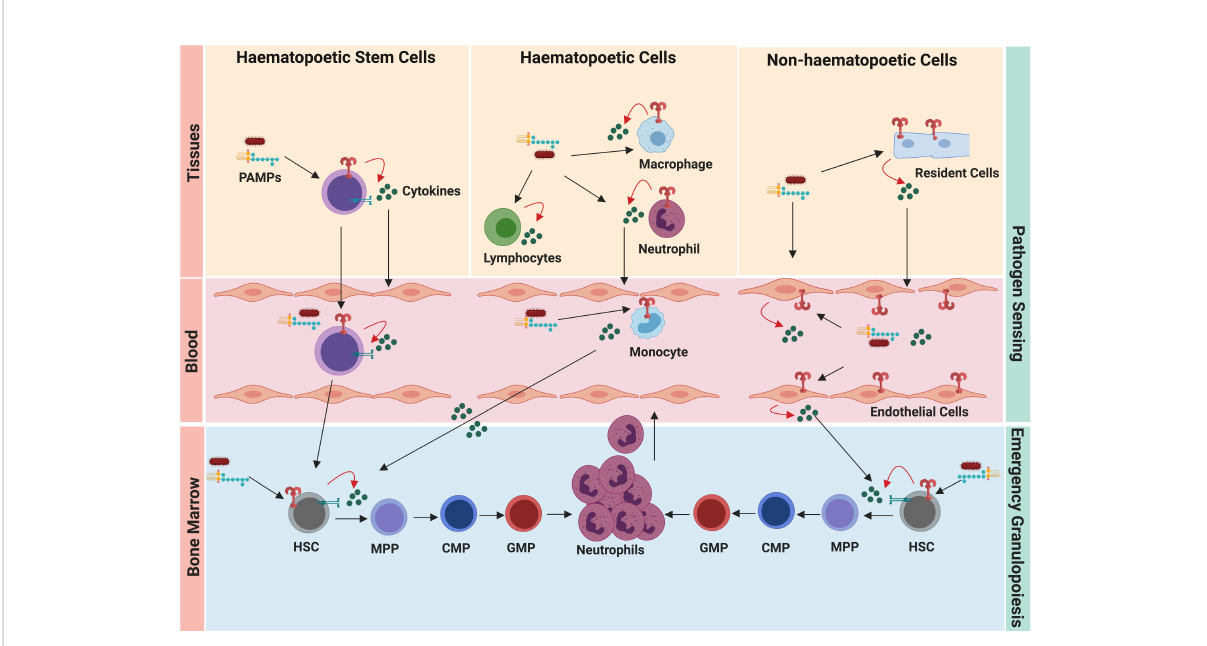
FIGURE 2 Pathogen sensing system of emergency granulopoiesis. During infection and in fl ammation, the hematopoietic cells, resident cells, and circulating HSCs sense disseminating pathogens and danger signals. Pathogen-induced granulopoiesis heavily depends upon TLR-signaling, which translates pathogen signals into molecular cues of granulopoiesis. TLR engagement on these cells results in the secretion of several granulopoietic growth factors (such as G-CSF, IL-6, CXCL1), which initiate signaling cascades in HSCs and neutrophil progenitors, thereby activating emergency granulopoiesis. Expression of TLRs by HSCs and endothelial cells facilitates more direct ways of initiating granulopoiesis compared to indirect activation of immune cells at the site of infection/in fl